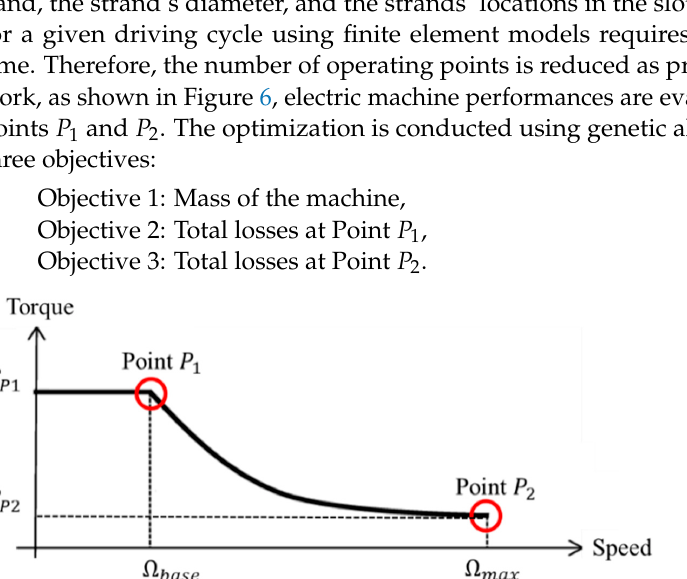
10 of 32 Figure 5. Nearest grid’s node to the center of the virtual conductor.